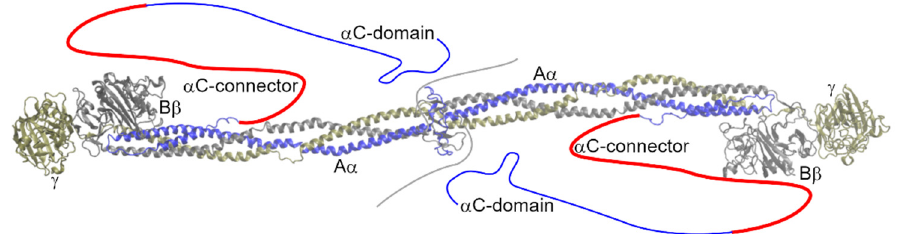
Figure 1. Structure of fibrinogen (3GHG; [5]). Missing parts of the molecule are sketched. The α C-connector is highlighted in red. Fibrinogen consists of two copies of the chains A α (629 AAs; numbering and count according to the nascent chain), B β (491 AAs), and γ (437 AAs). The chains are encoded by three genes, FGA , FGB , and FGG , all of which are located in an approximately 50 kb region on chromosome 4 (4q31.3–4q32.1) [6]. Fibrinogen is predominantly synthesized